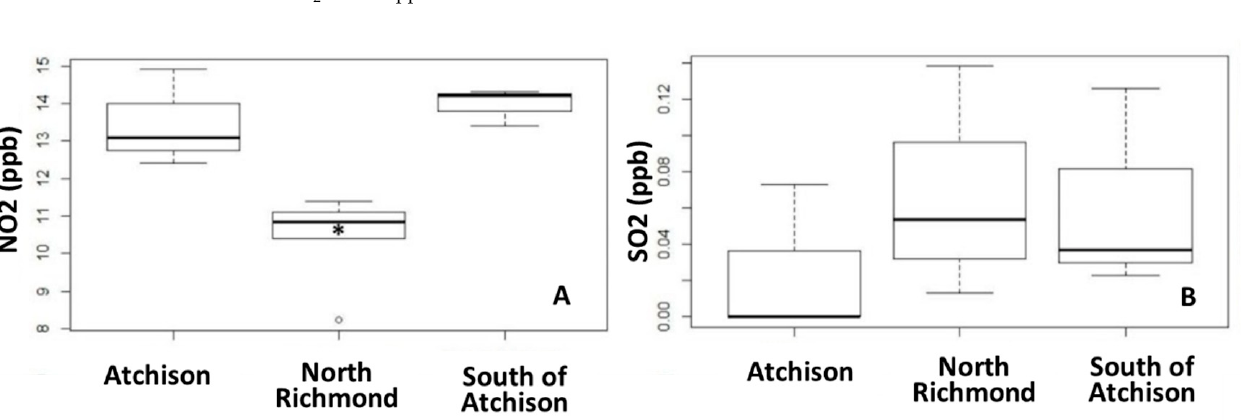
Figure 2. Boxplots displaying measured concentrations. ( A ) NO 2 and ( B ) SO 2 for each Richmond neighborhood monitored in our study (21 December–15 January 2018). Asterisk (*) indicates that North Richmond had significantly lower ( p < 0.05) NO 2 concentrations compared to all other monitored neighborhoods. Unfilled circles indicate outliers.